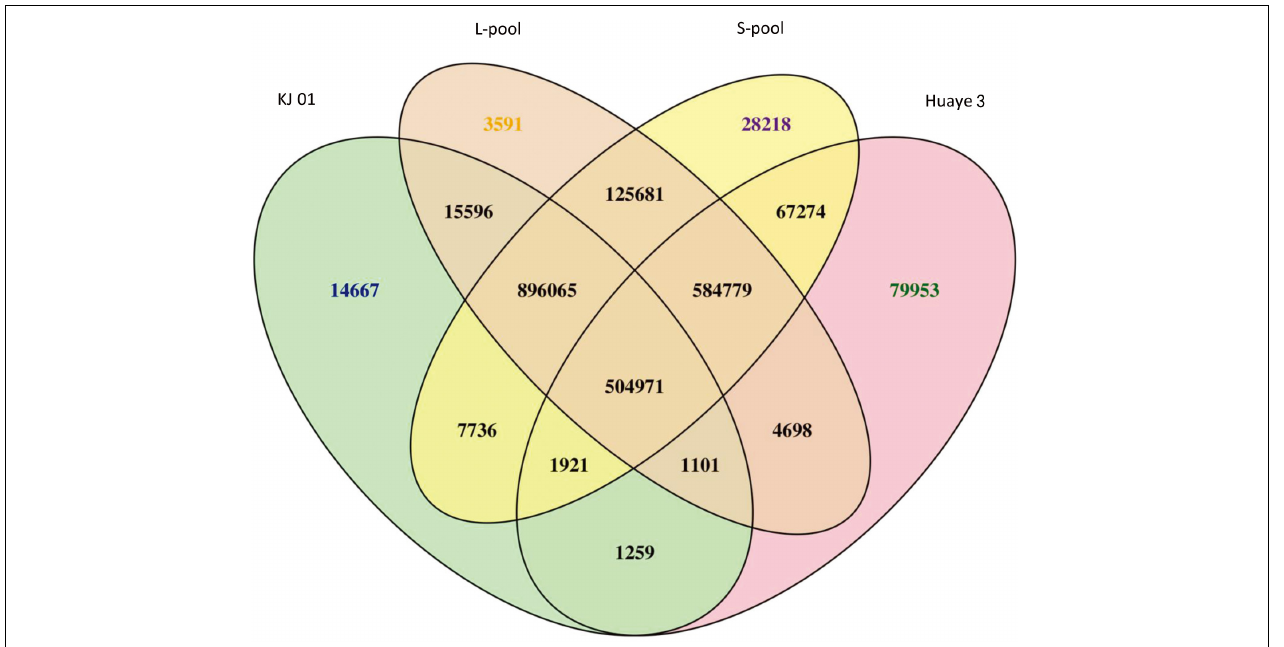
FIGURE 2 | Venn diagram of SNP statistics between samples. The number of varying sites considers only whether the location is the same, not whether the genotype is the same.